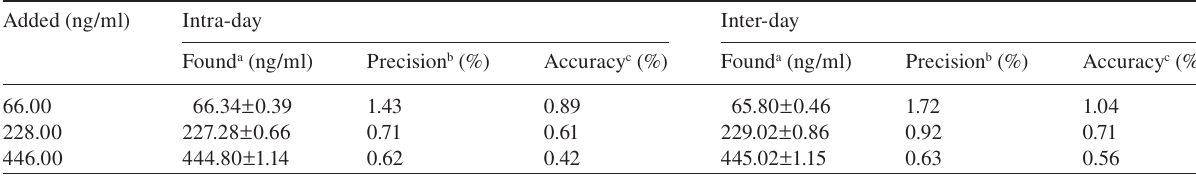
Table 2 Precision and accuracy of the SWAdSV method (n = 6).